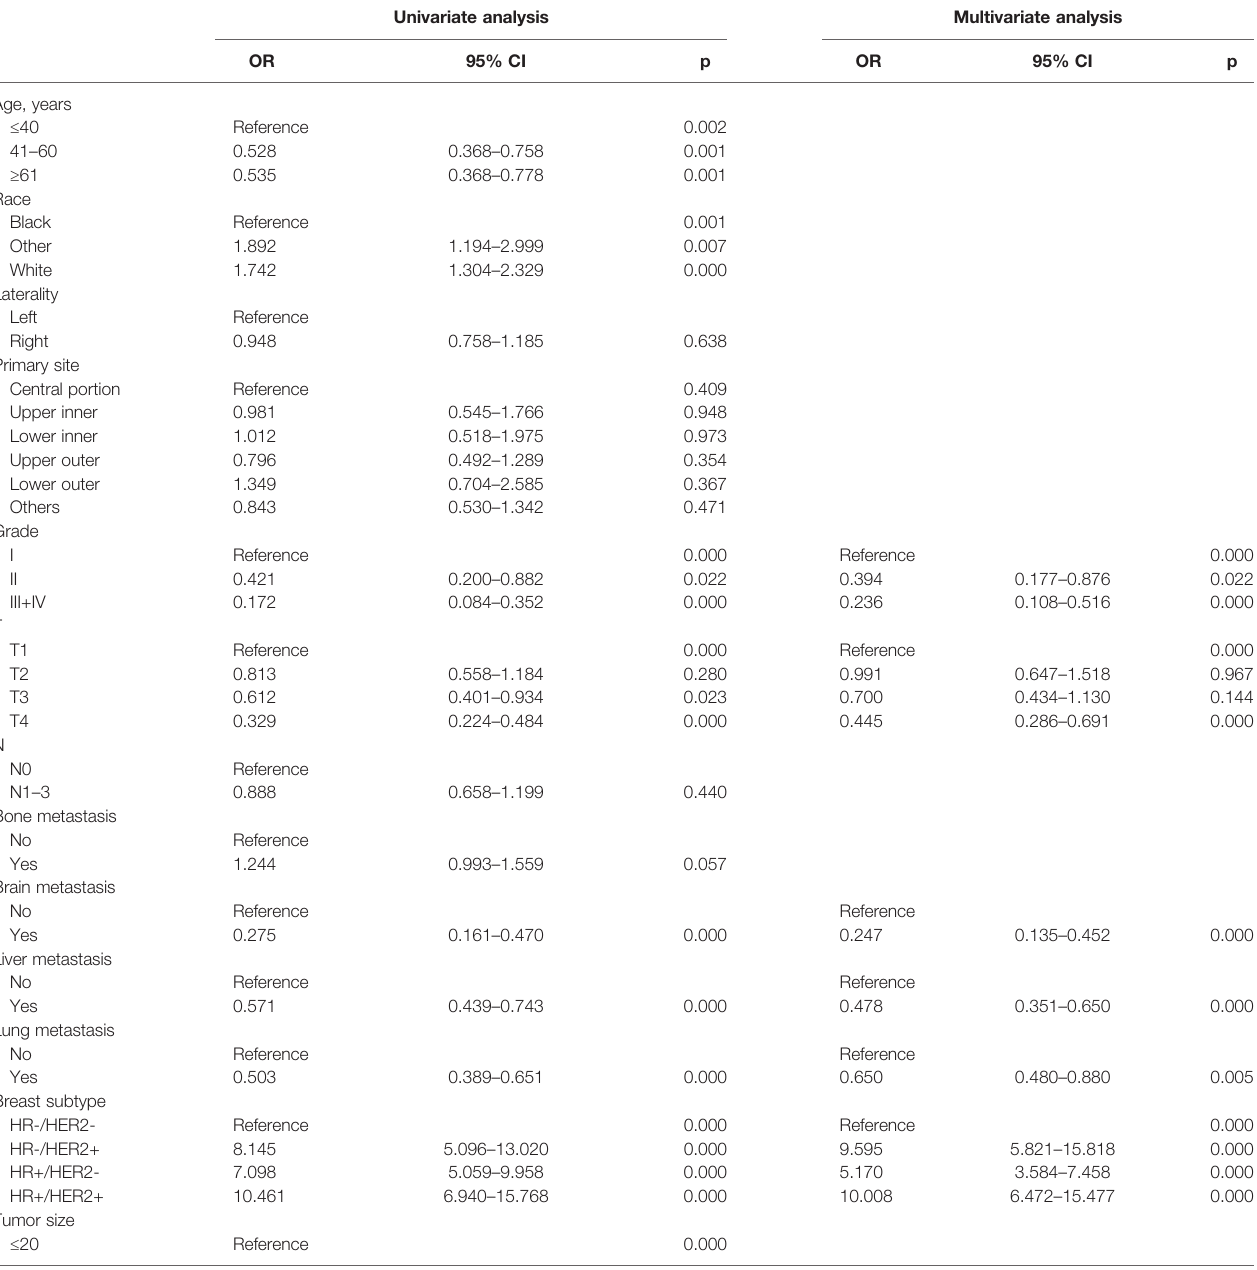
TABLE 6 | Univariate and multivariate logistic analyses of bene fi t in female patients with stage IV IDC of breast. Univariate analysis Multivariate